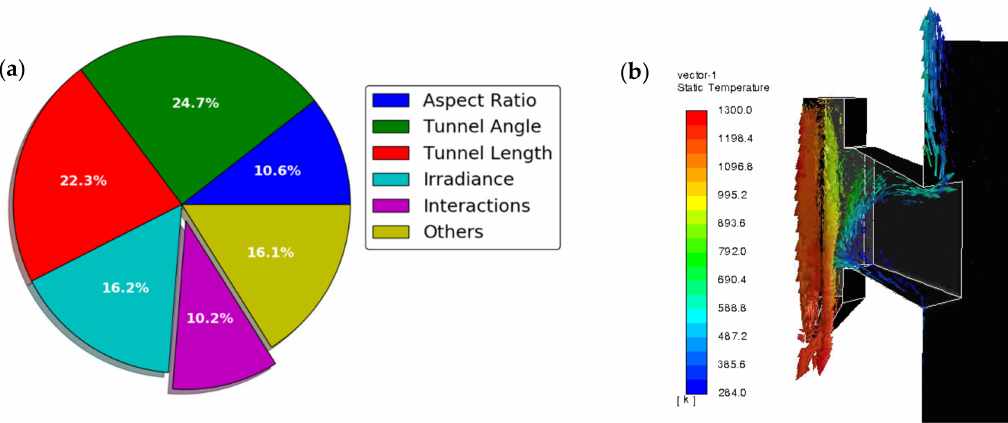
Figure 8. Sobol indices for different geometric parameters of a FPR ( a ) and the resulting optimized cavity yielding simulated thermal efficiencies up to 86.9% ( b )